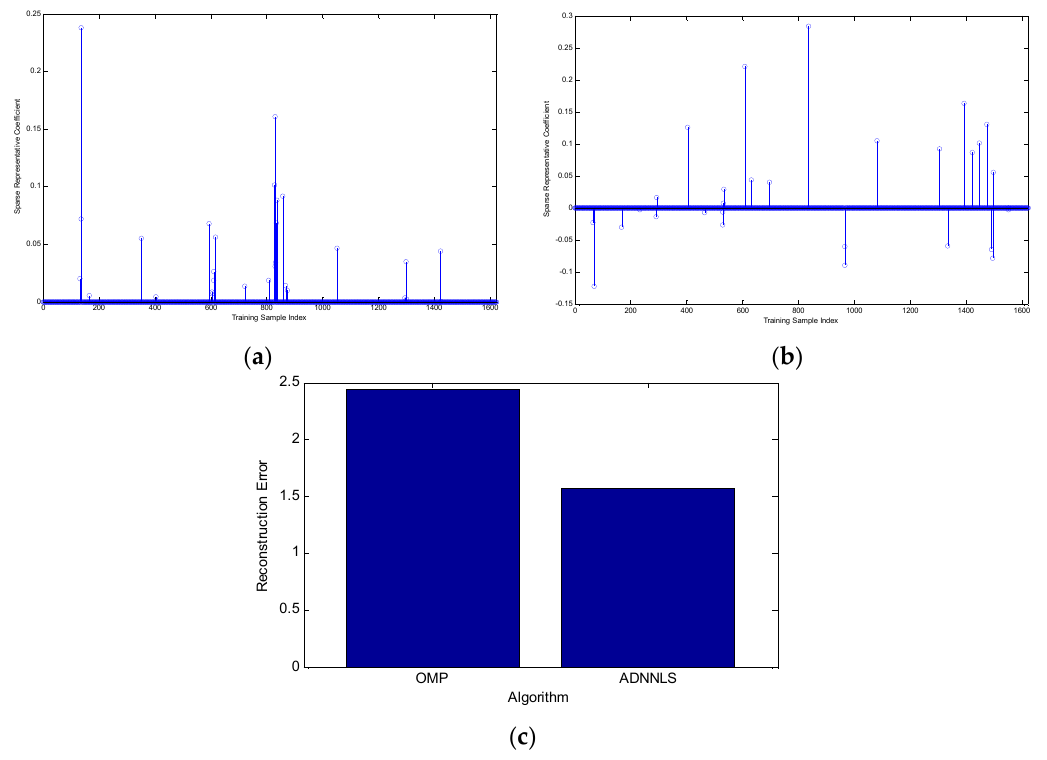
Figure 14. ( a ) Sparse coefficient vector obtained based on ADNNLS algorithm. ( b ) Sparse coefficient vector obtained based on OMP algorithm. ( c ) Reconstruction error of two algorithms.